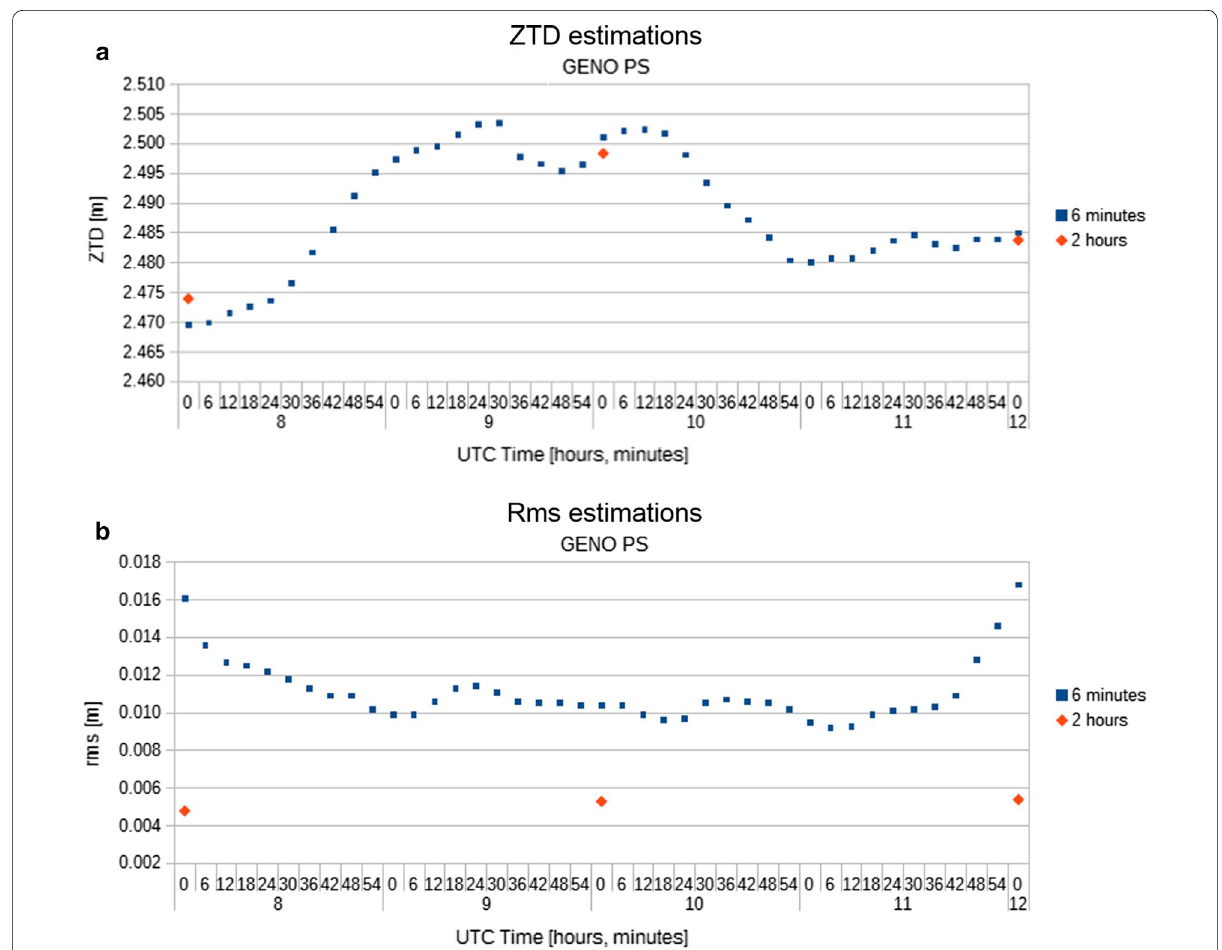
Fig. 15 Six-minute (blue dots) and 2-h (red dots) ZTD estimates ( a ). A difference of a few millimeters was noted. Six-minute (blue dots) and 2-h (red dots) ZTD rms values ( b ). The ZTD and rms estimates refer to November 4,